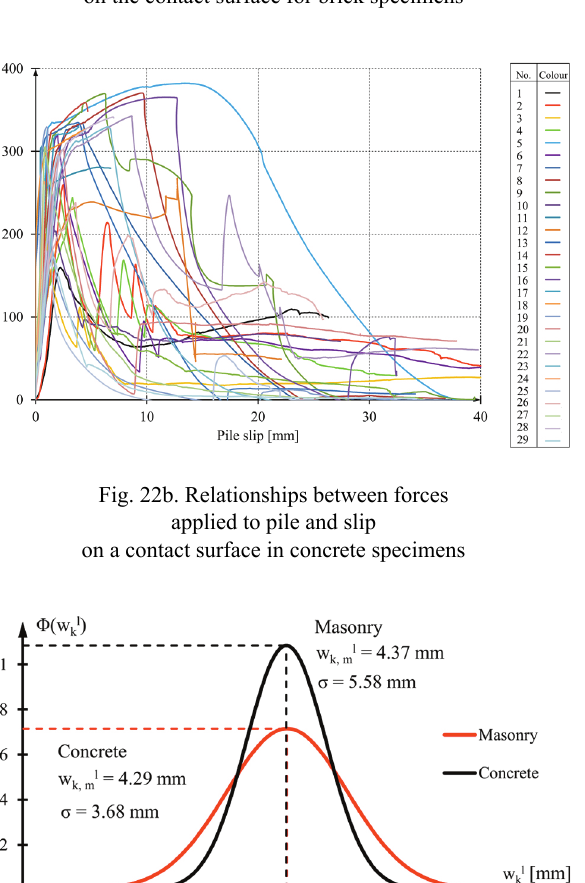
Fig. 22a. Relationships between loads applied to pile and slip on the contact surface for brick specimens